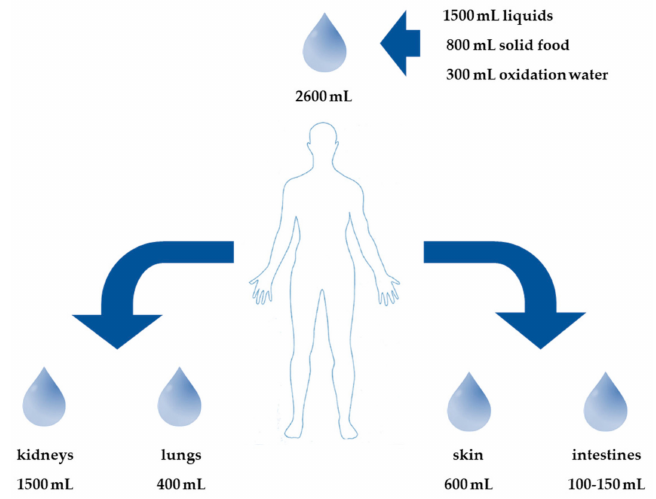
Figure 3. Fluid balance [35]. This figure shows the sites involved in fluid